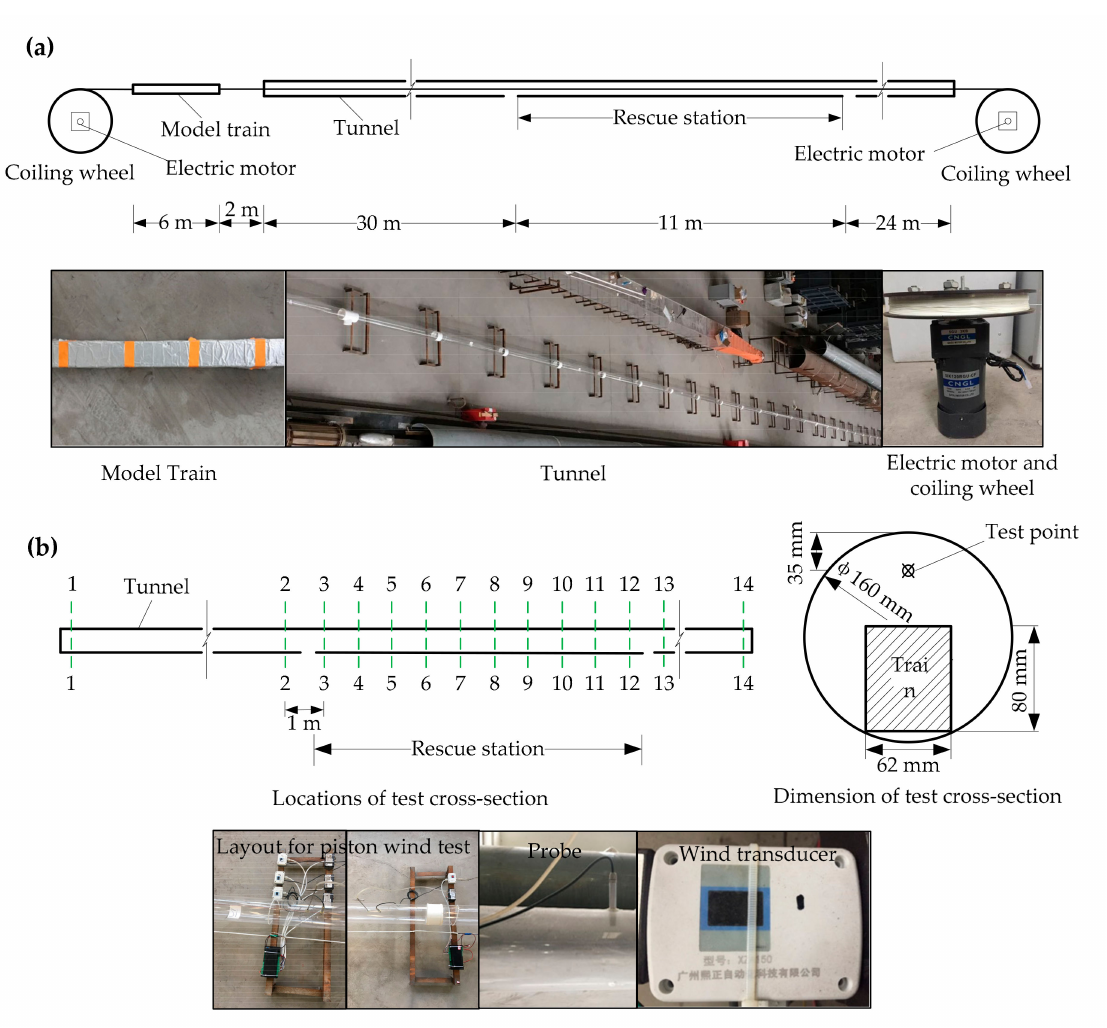
Figure 6. Schematic of experiment layout. ( a ) Top view of the experimental platform. ( b ) Locations and dimension of test cross-sections.